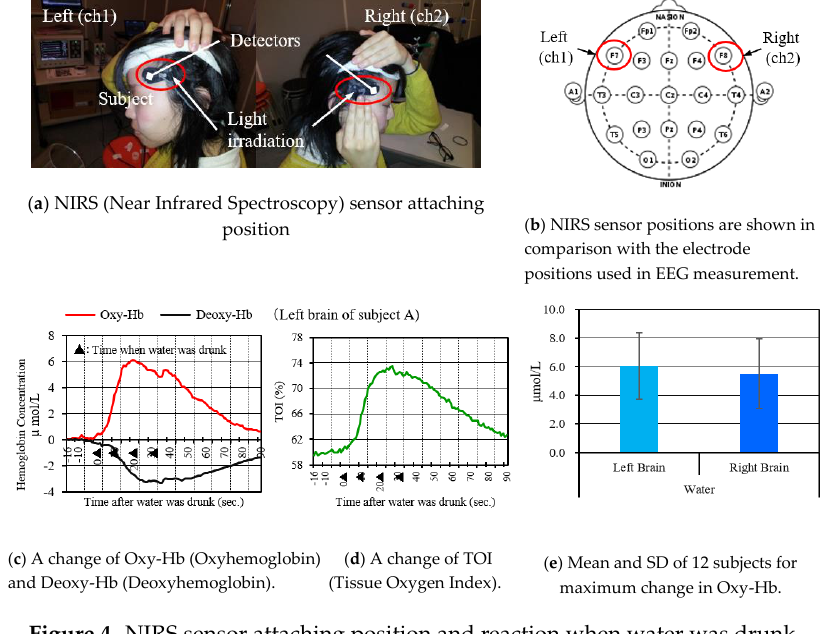
Figure 4. NIRS sensor attaching position and reaction when water was drunk.